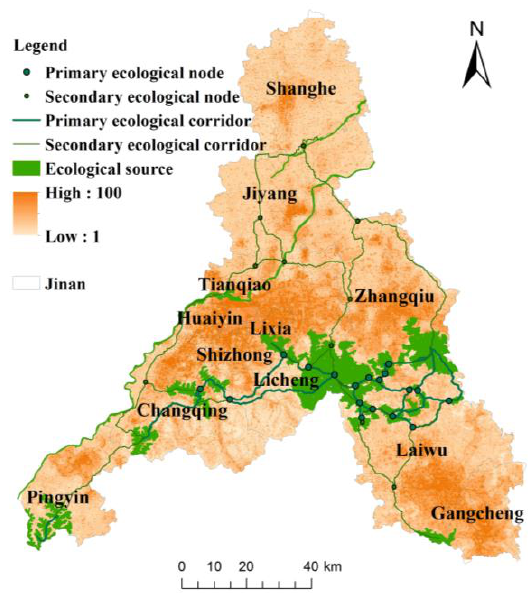
Figure 10. Spatial distribution of ecological network.